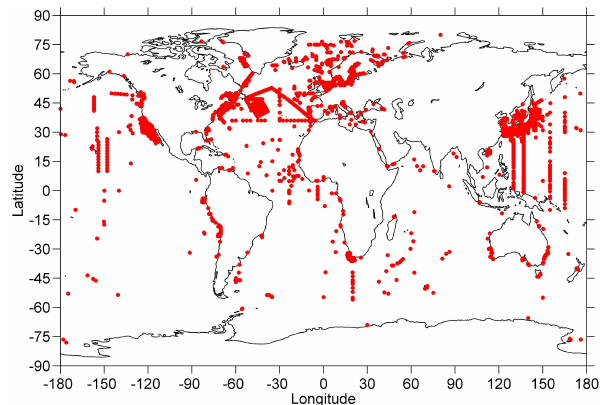
Fig. 1. Station locations (red dots) of digitized oxygen concentra- tion time series from refereed journal publications.